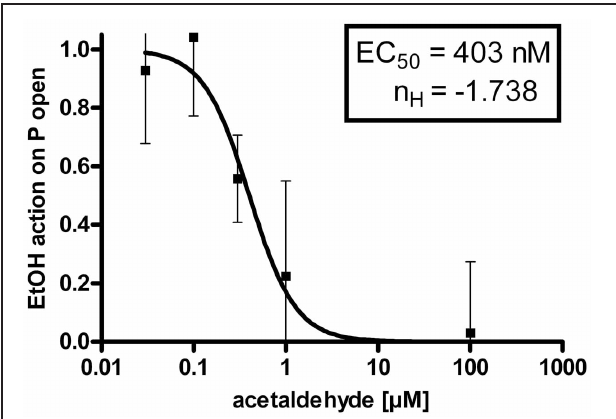
FIGURE 3 | Dose-response-relationship: The EtOH effect on BK channel open probability (P open) was progressively inhibited by increasing concentrations of ACA at the intracellular side of the membrane (EC 50 = half maximal effective concentration = 403 ± 108nM, n H = Hill coefficient = − 1 . 738 ± 0 . 731, semilogarithmic graph).